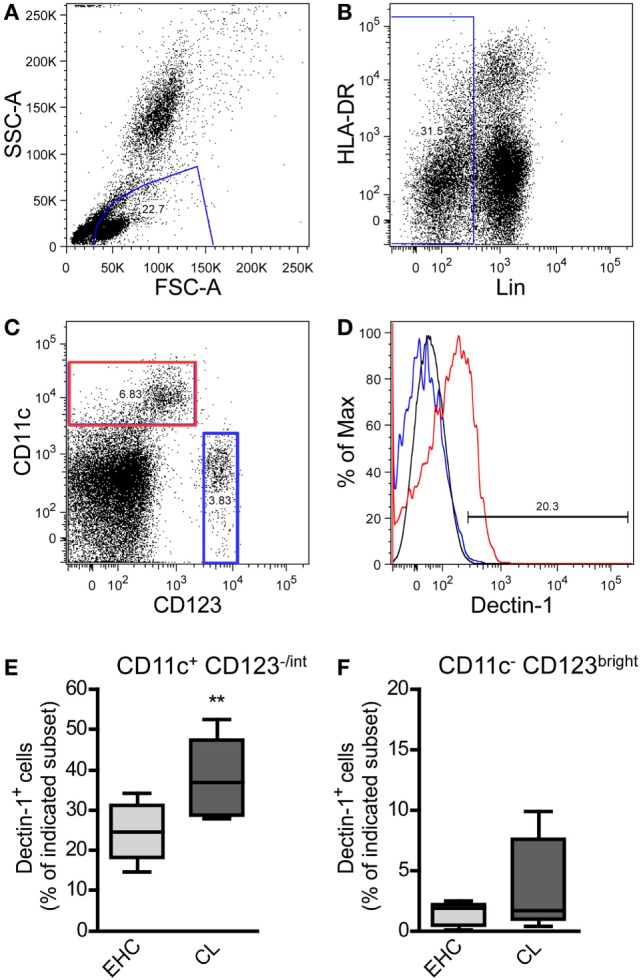
Characterization of Dectin-1+ DC subsets in blood samples from patients suffering from cutaneous leishmaniasis (CL). Peripheral blood samples from patients suffering from CL and Ethiopian healthy controls (EHCs) were stained for CD11c, Dectin-1, HLA-DR, CD123, and a lineage cocktail (anti-CD3, anti-CD14, anti-CD16, anti-CD19, anti-CD20, and anti-CD56) abbreviated as Lin. The following gating strategy was used. (A) FSC and SSC plots were used to define the leukocyte population. (B) Lin− cells were selected for further analysis. (C) Lin− cells were differentiated into CD11c+/CD123−/int and CD11c−/CD123bright populations displayed as dot plot. (D) The histogram plot indicates the expression of Dectin-1 on CD11c+/CD123−/int (highlighted in red) and CD11c−/CD123bright cells (highlighted in blue). The black line represents the isotype control. (E,F) The frequency of Dectin-1+ cells within the indicated subset is shown by box plot diagrams. Number of analyzed donors, n = 5. Data were analyzed using Student’s t-test (**p = 0.004).